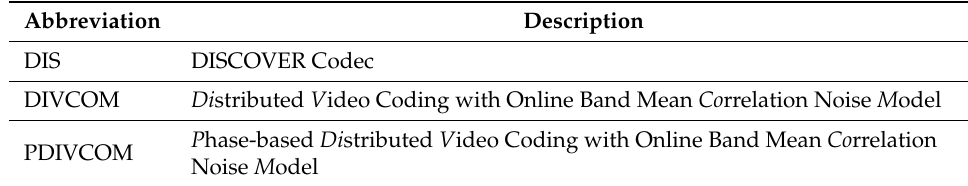
Table 1. Abbreviations of different video